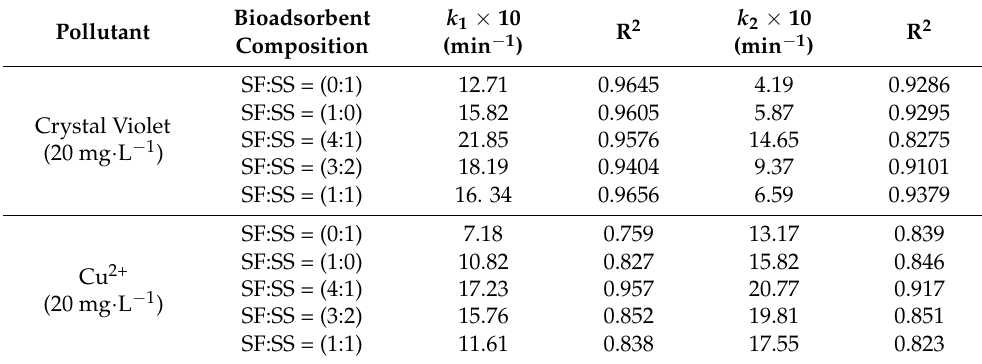
Table 2. The parameters of the pseudo-first-order and pseudo-second-order models for the adsorption of CV and Cu 2+ using SF:SS composite adsorbent.